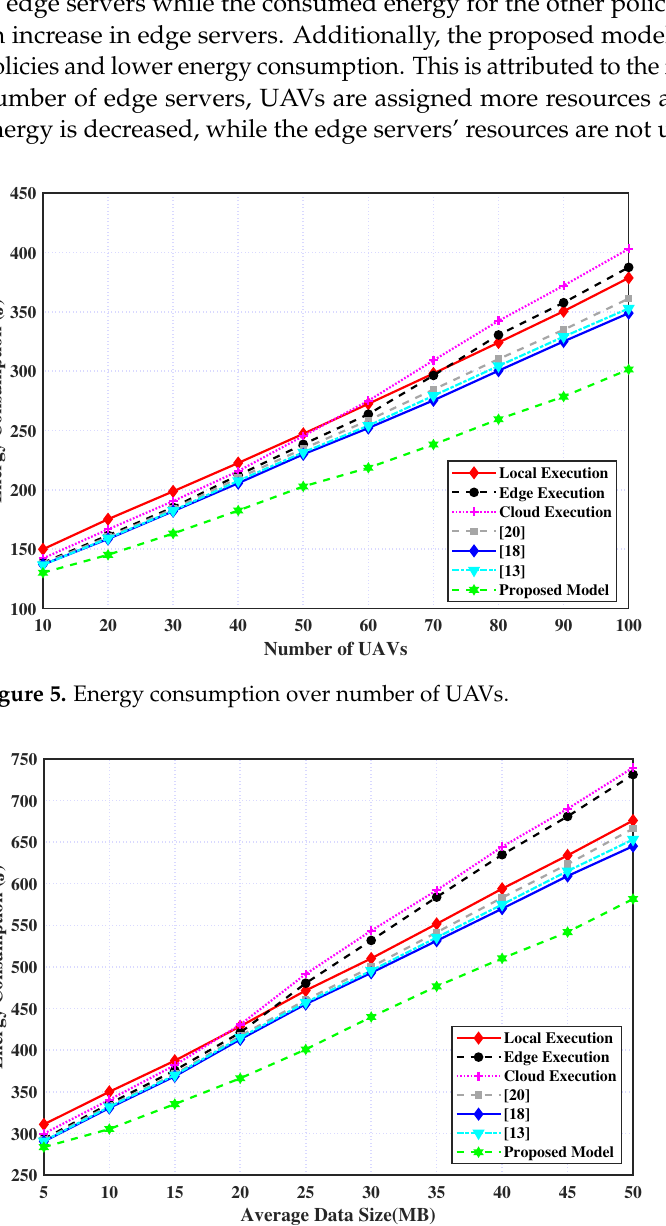
Figure 6. Energy consumption over data